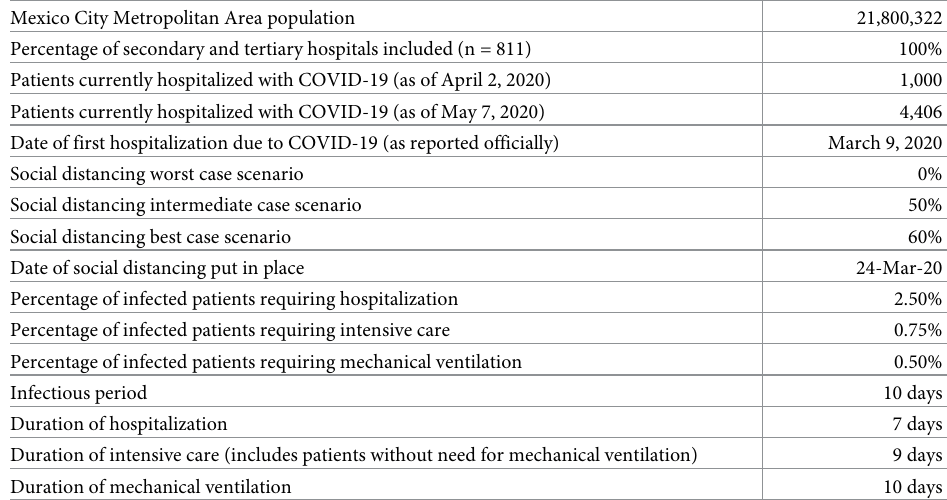
Table 1. Inputs used for CHIME projections modeled on April 2 and May 7,